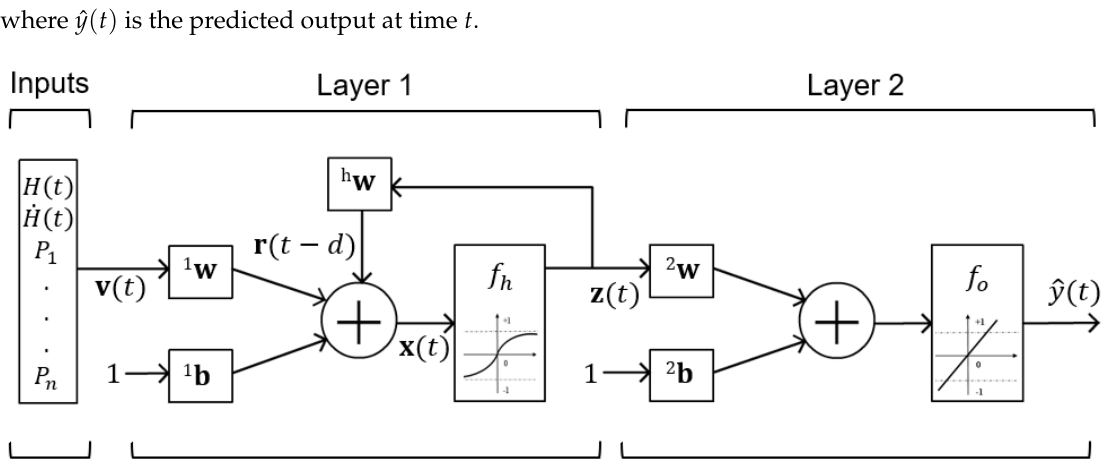
Figure 4. Schematic diagram of the Preisach-RNN